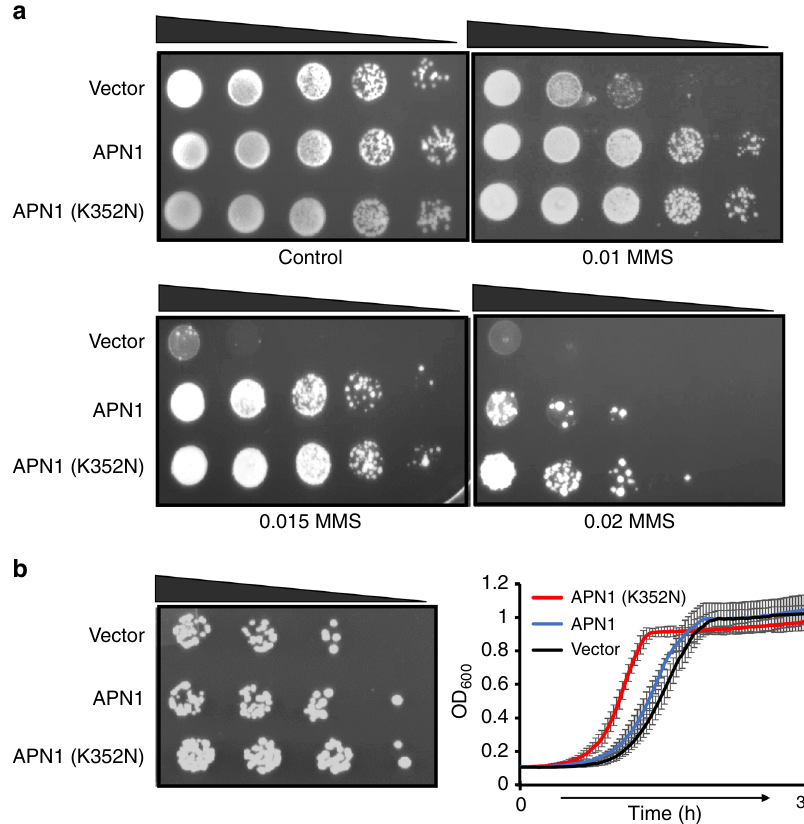
Fig. 5 Effect of APN1 K352N mutation on cell survival under genotoxic stress. a Spot assay for survival effect of APN1 K352N mutation under MMS stress. Plates with YNB medium without His were supplemented with indicated amounts of MMS (%), and Δ APN1 cells harboring an empty vector (p413ADH), or vectors expressing endogenous APN1 or mutated APN1 spotted with 10-fold dilution onto plates. b Spot (left) and growth (right) assays for assessing viability of cells with mutated APN1 in response to oxidative DNA damage using a thiol peroxidase null strain ( Δ 7). Each spot assay was repeated three times, and the growth curve shown is the mean of three independent measurements. Expression of APN1 K352N mutation signi fi cantly improved the growth of Δ 7 cells, compared to cells expressing non-mutated APN1 (two-sided t test, p ≤